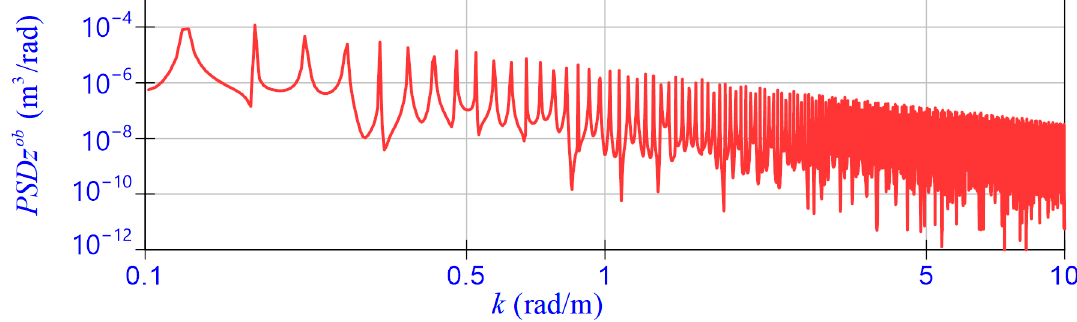
Figure 3. Power spectra density of displacement excitation in an A road class.